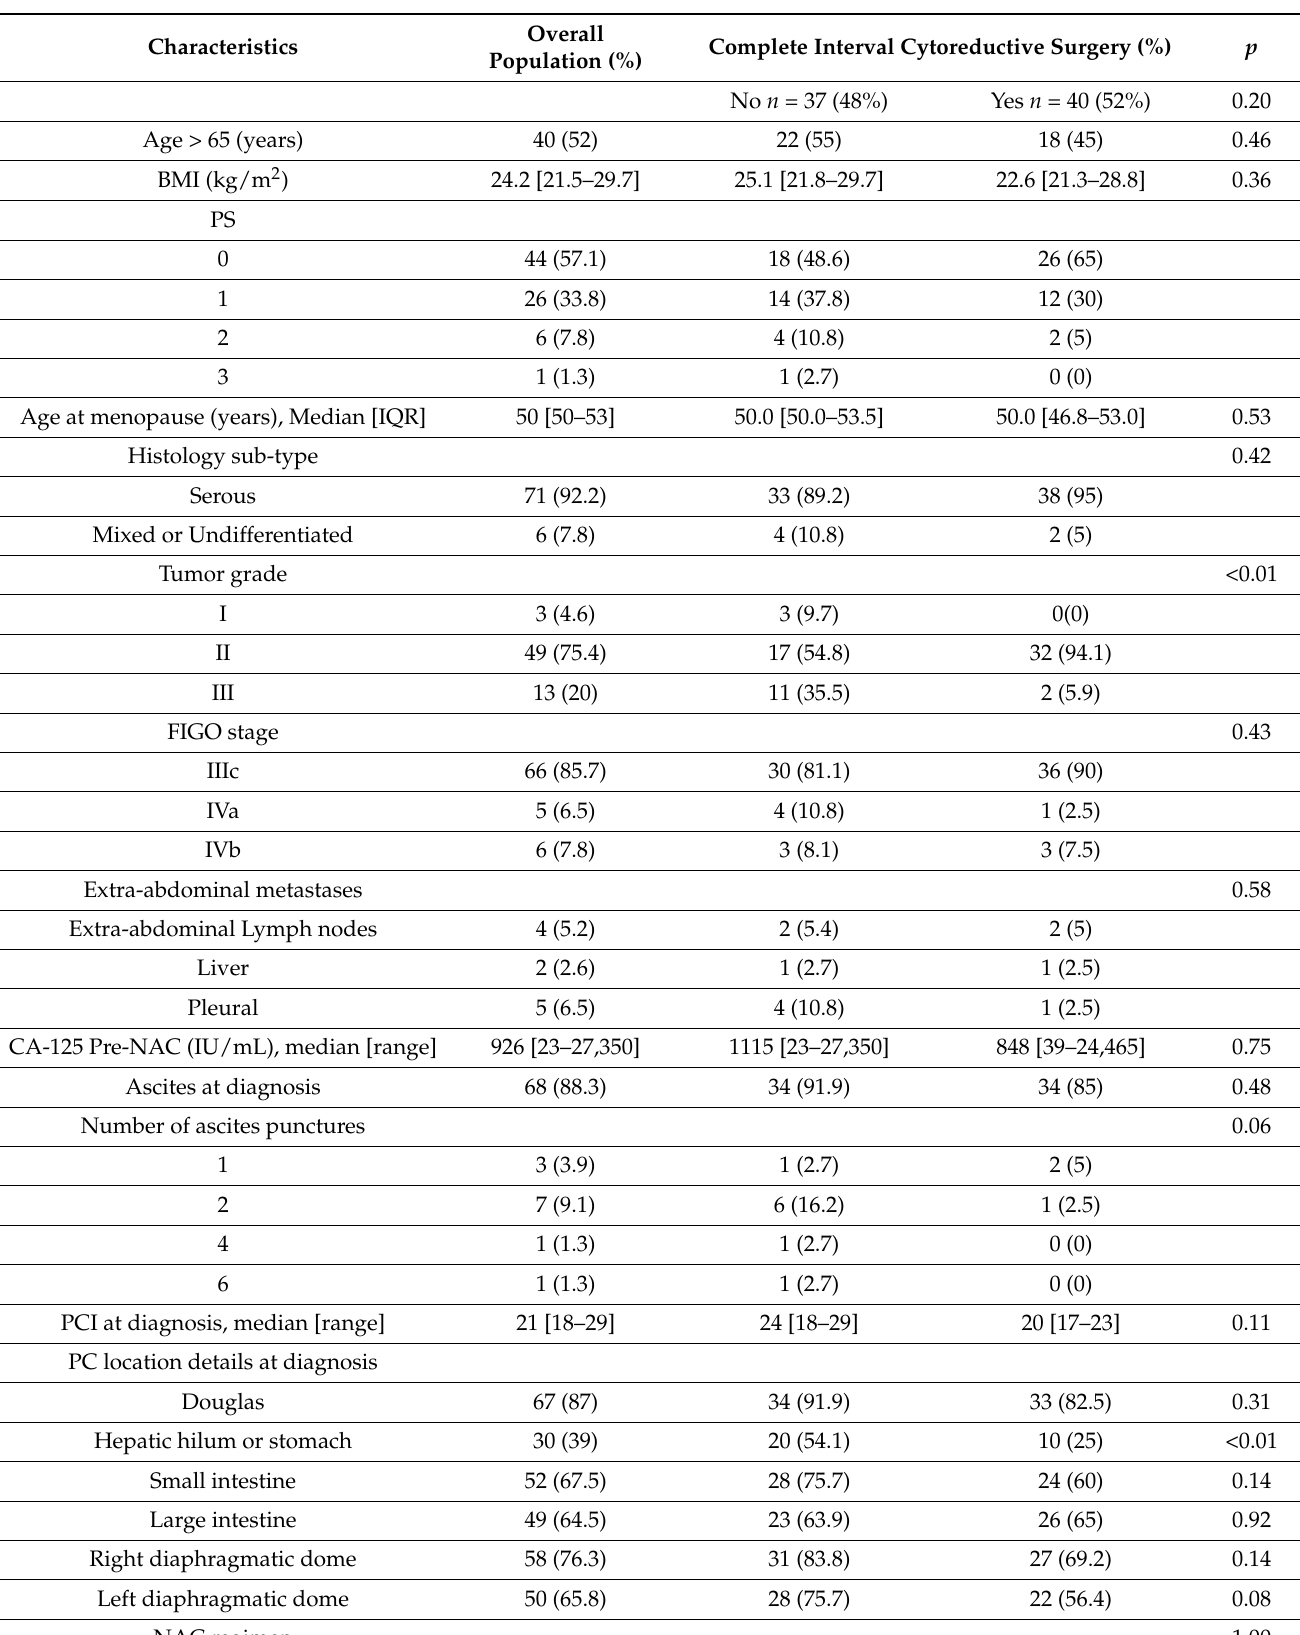
Table 1. Demographic, clinical, and biological